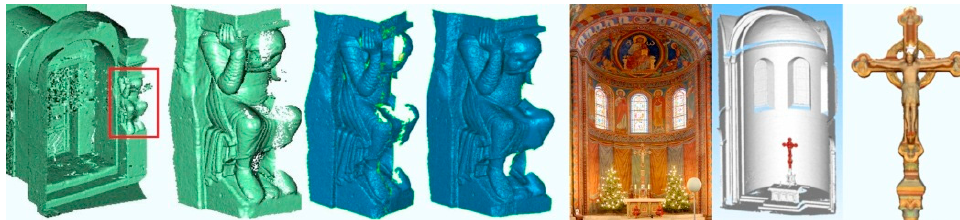
Figure 4. Constructed 3D model of the imperial cathedral in Königslutter, Germany—View of the four fronts in AutoCAD.